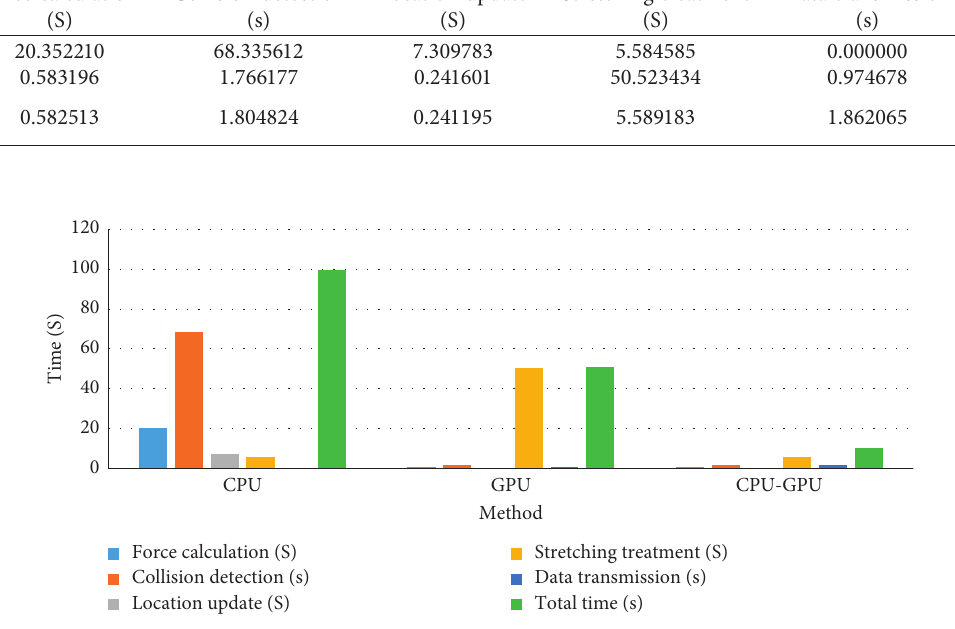
Figure 7: Performance comparison of each stage.